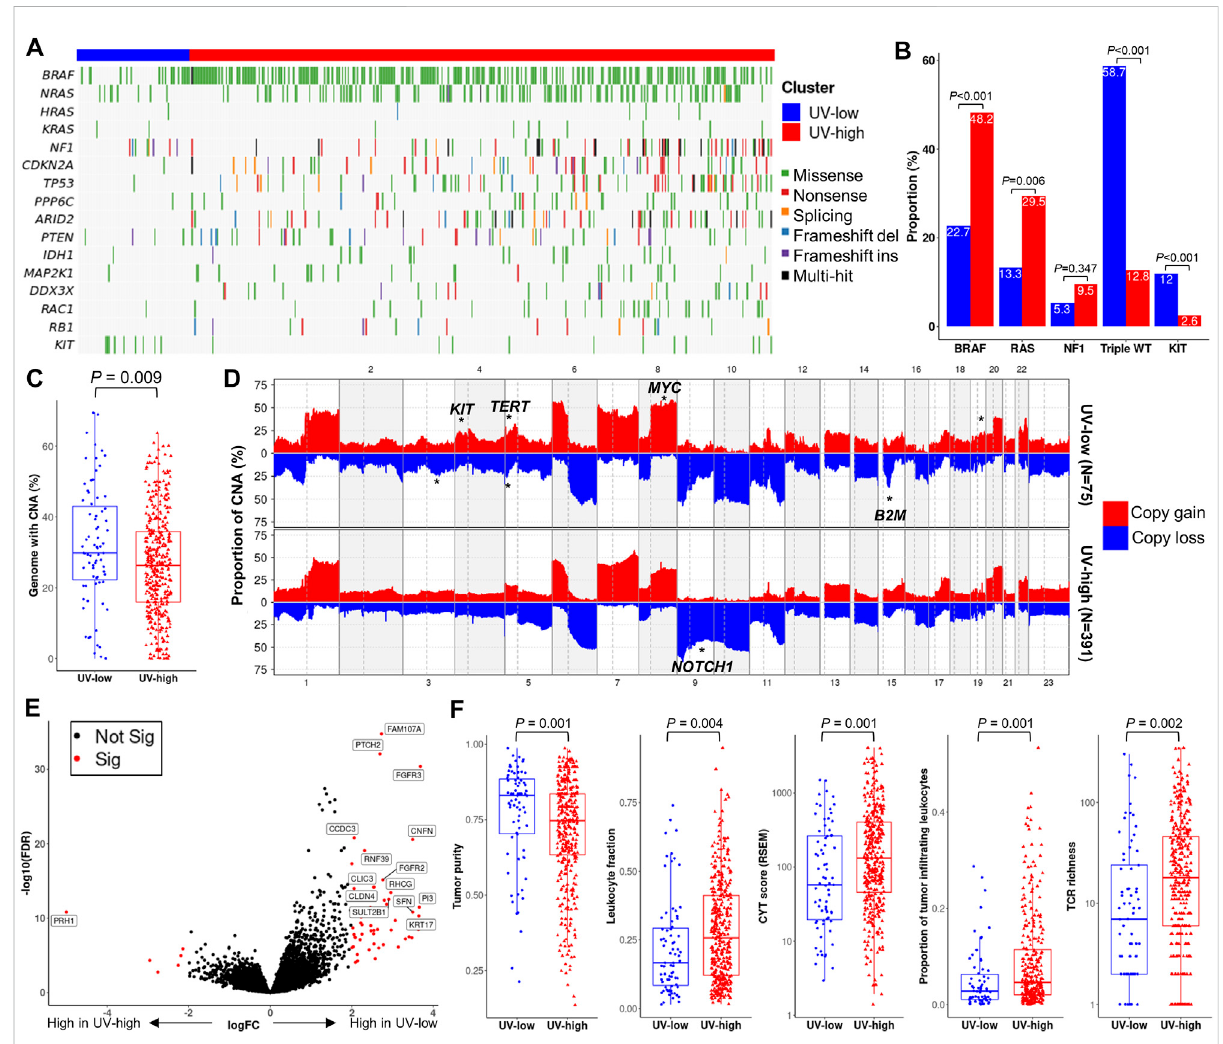
FIGURE 4 Genomic andfunctional characterization. (A) Mutationallandscapeofknown drivergenes ofmelanoma. Samples (column) arearranged bythe weight of SigB (Same as Figure 1B). (B) Proportion of mutational class ( BRAF hotspot, RAS hotspot, NF1 , triple wild type (WT)) and KIT non-silent mutations. p -value was calculated using a two-sided chi-square test. (C) Boxplot showing the proportion of genomes with copy number alteration (CNA). p -value was calculated using a two-sided Mann-Whitney U test. (D) Genome-wide CNA plot of each cluster. CNA regions with statistically signi fi cantenrichment(chi-squaretest p < 0.001)aremarkedwithasterisksonputative drivergenes. (E) Volcanoplotwith x -axis (logfold change) and y -axis (- log false discovery rate (FDR)), in which genes are colored by signi fi cance (FDR < 0.01) (red, signi fi cant; black, non-signi fi cant). Representative differentially expressed genes are marked with gene names. (F) Boxplot of tumor purity and representative parameters of tumor immunity. p -value was calculated using a two-sided Mann-Whitney U